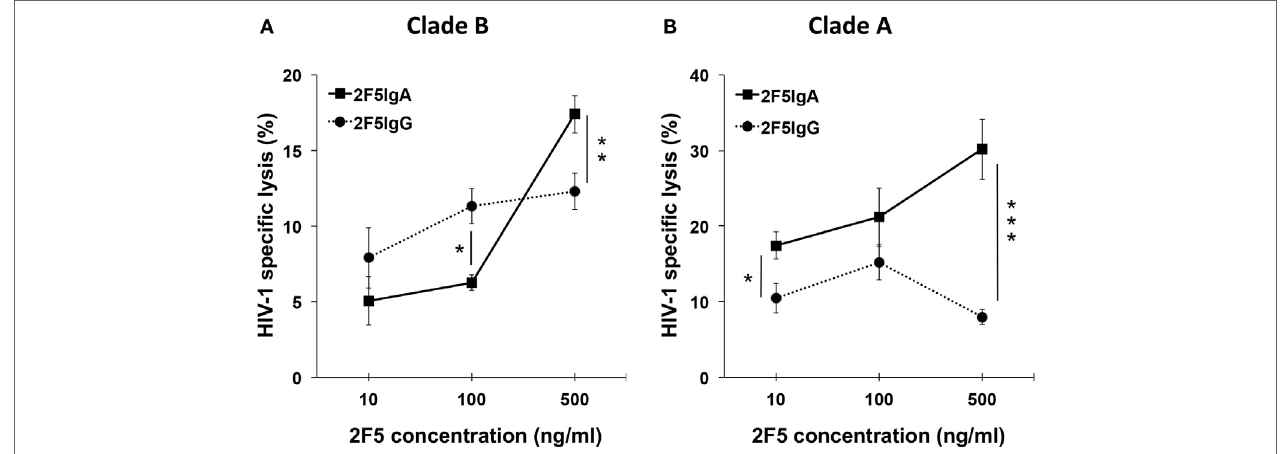
FigUre 2 | Human immunodeficiency virus-1 (HIV-1)-specific antibody-dependent cellular cytotoxicity (ADCC) triggered by 2F5-IgA compared to 2F5-IgG. Target CD4 + T CEM-NK r cells infected with (a) HIV-1 Clade B (JR-CSF) or (B) green fluorescent protein (GFP)-reporter CD4 high CCR5 high T-cell lines infected with HIV-1 Clade A (92UG031) were stained with PKH26 and then incubated with the indicated concentrations of 2F5-IgA or 2F5-IgG for 30 min at room temperature (RT), prior to addition of effector monocytes (effector:target ratio, 10:1). After 4 h, the percent of infected living (Gag + or GFP + ) target cells was measured by flow cytometry. The percent of ADCC was calculated using the formula: 100 × (% of infected/PKH26 + target cells without antibody − % of infected/PKH26 + target cells with antibody)/(% of infected/PKH26 + target cells without antibody). Values represent means of HIV-1-infected target cell-specific lysis ± SEM, from six independent experiments performed in duplicate or triplicate for each clade, * p < 0.05, ** p < 0.02, and *** p < 0.005, unpaired Student’s t -test of 2F5-IgA versus 2F5-IgG- mediated